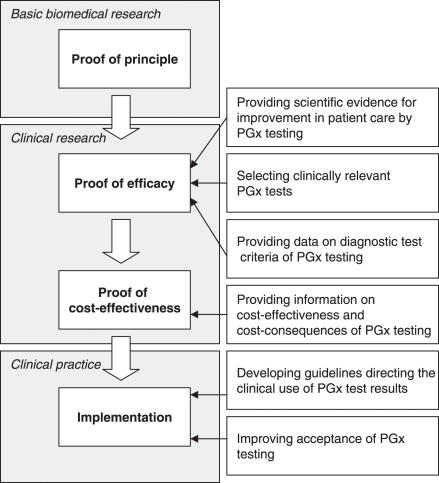
Consecutive Phases and Associated Challenges on the Road to Clinical Implementation of Pharmacogenomics